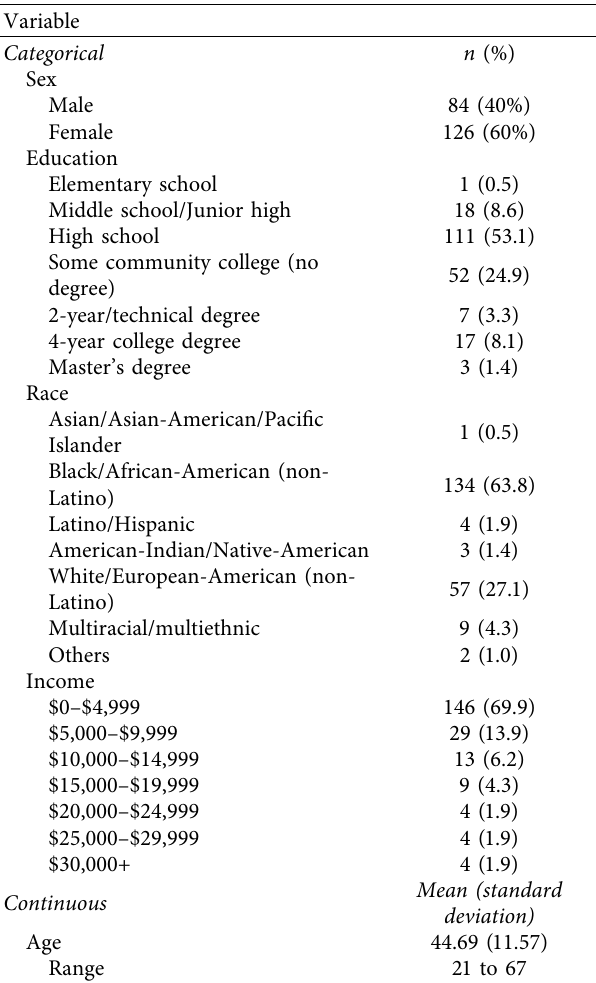
Table 1: Sample characteristics: demographics